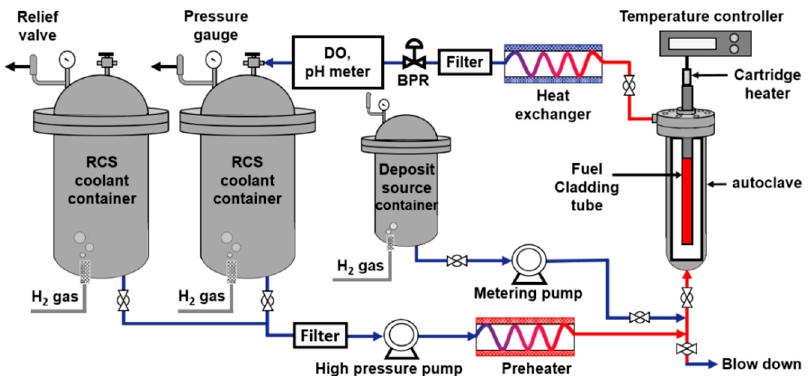
Figure 1. The coolant circulation loop system for fuel-deposit deposition and zinc incorporation.